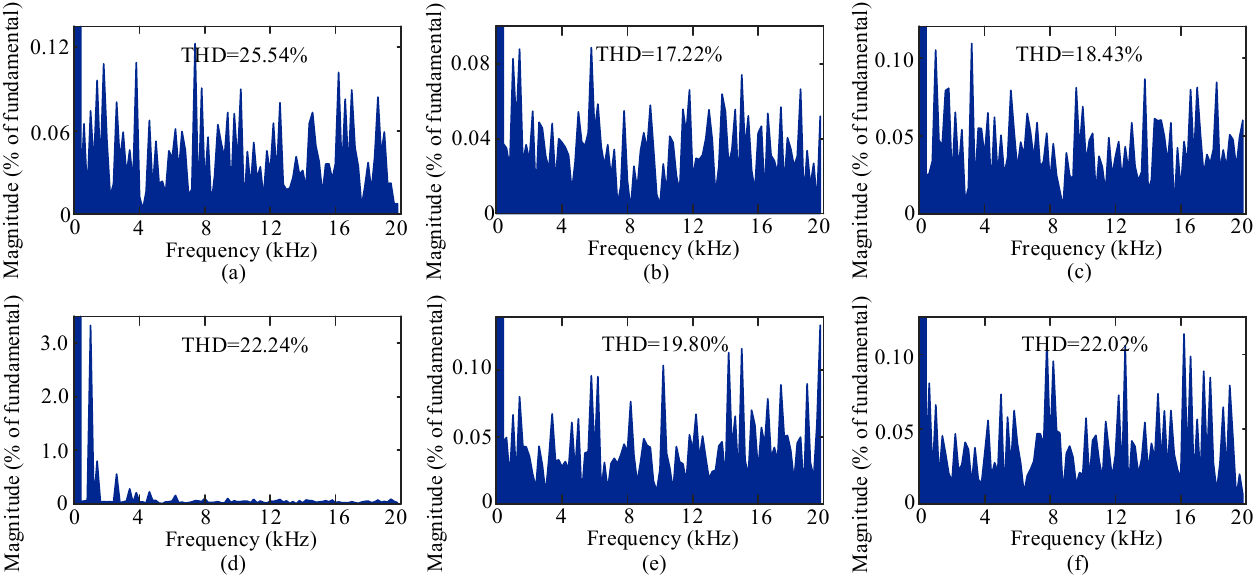
Figure 4. Inverter line voltage total harmonic distortions (THDs) with the modulation techniques: ( a ) SPWM, ( b ) THPWM, ( c ) CSVPWM, ( d ) THSDPWM, ( e ) TDBCPWM, and ( f ) SDBCPWM.